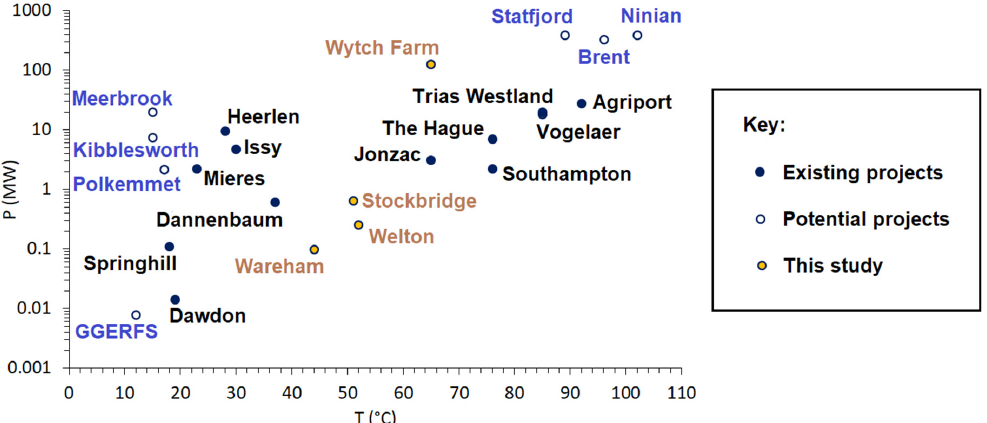
Figure 11. Comparison of thermal output power, P, versus output temperature for the suite of low-temperature geothermal sites listed in Table 8. Note the logarithmic scale for power, which means that the di ff erence in calculation procedure compared with that used for Tables 6 and 7 has little e ff ect on where projects